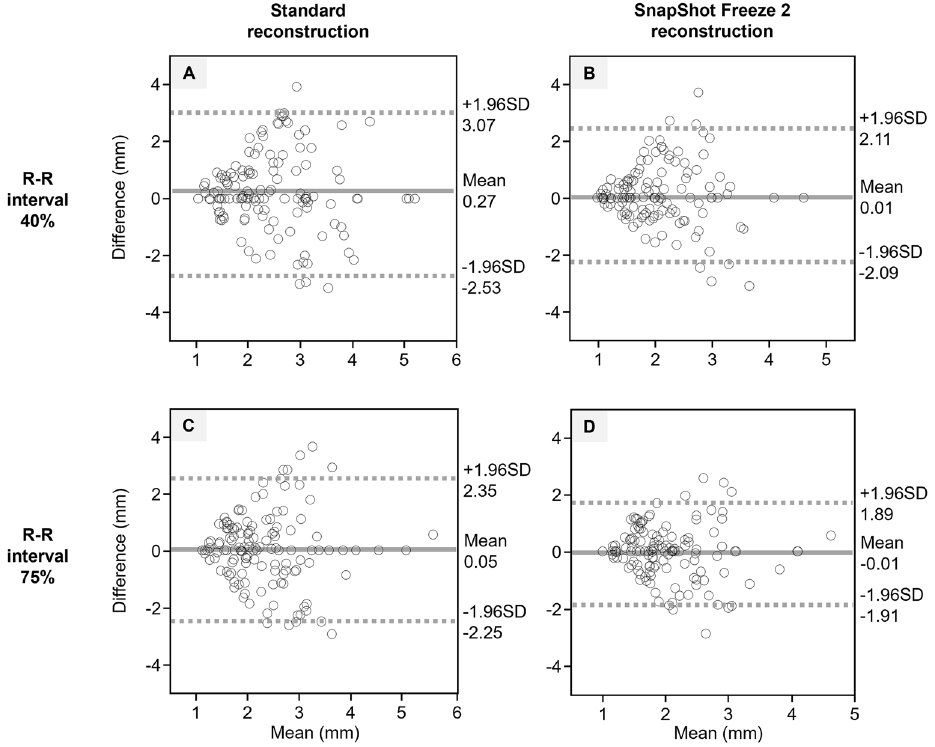
Figure 2. Bland–Altman plot analysis of the intraobserver agreement with respect to the edge rise distance. Standard- and SSF2 reconstruction at an R-R interval of 40% ( A and B ) and standard- and SSF2 reconstruction at an R-R interval of 75% ( C and D ). The solid line represents the mean difference, the dashed lines represent the 95% limit of agreement (mean difference ± 1.96 SD). SD = standard deviation.